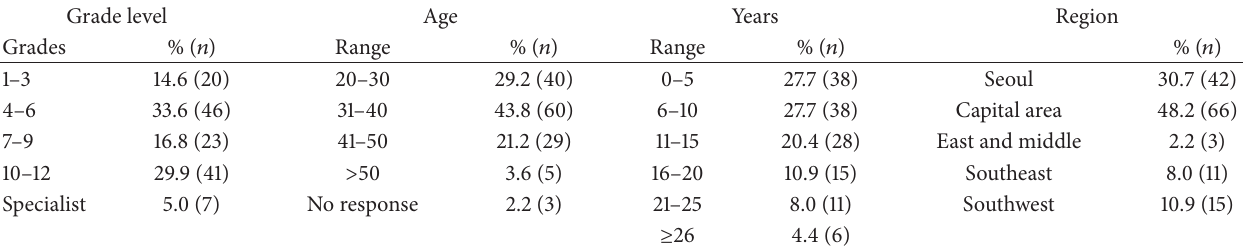
Table 1: Grade level, age, teaching experience, and region of